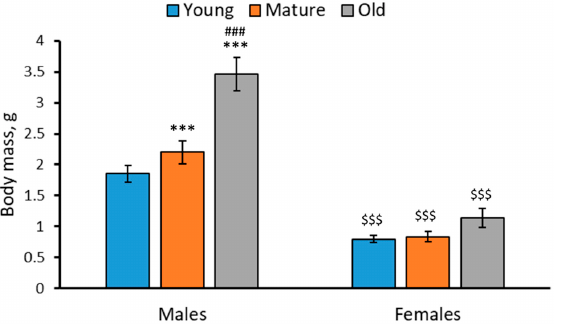
Figure 1. Body mass (g) in 2 (young)-, 4 (mature)- and 7 (old)-month-old males and females of N. furzeri . *** p < 0.001 vs. young males; ### p < 0.001 vs. mature males; $$$ p < 0.001 vs. males of the same age.